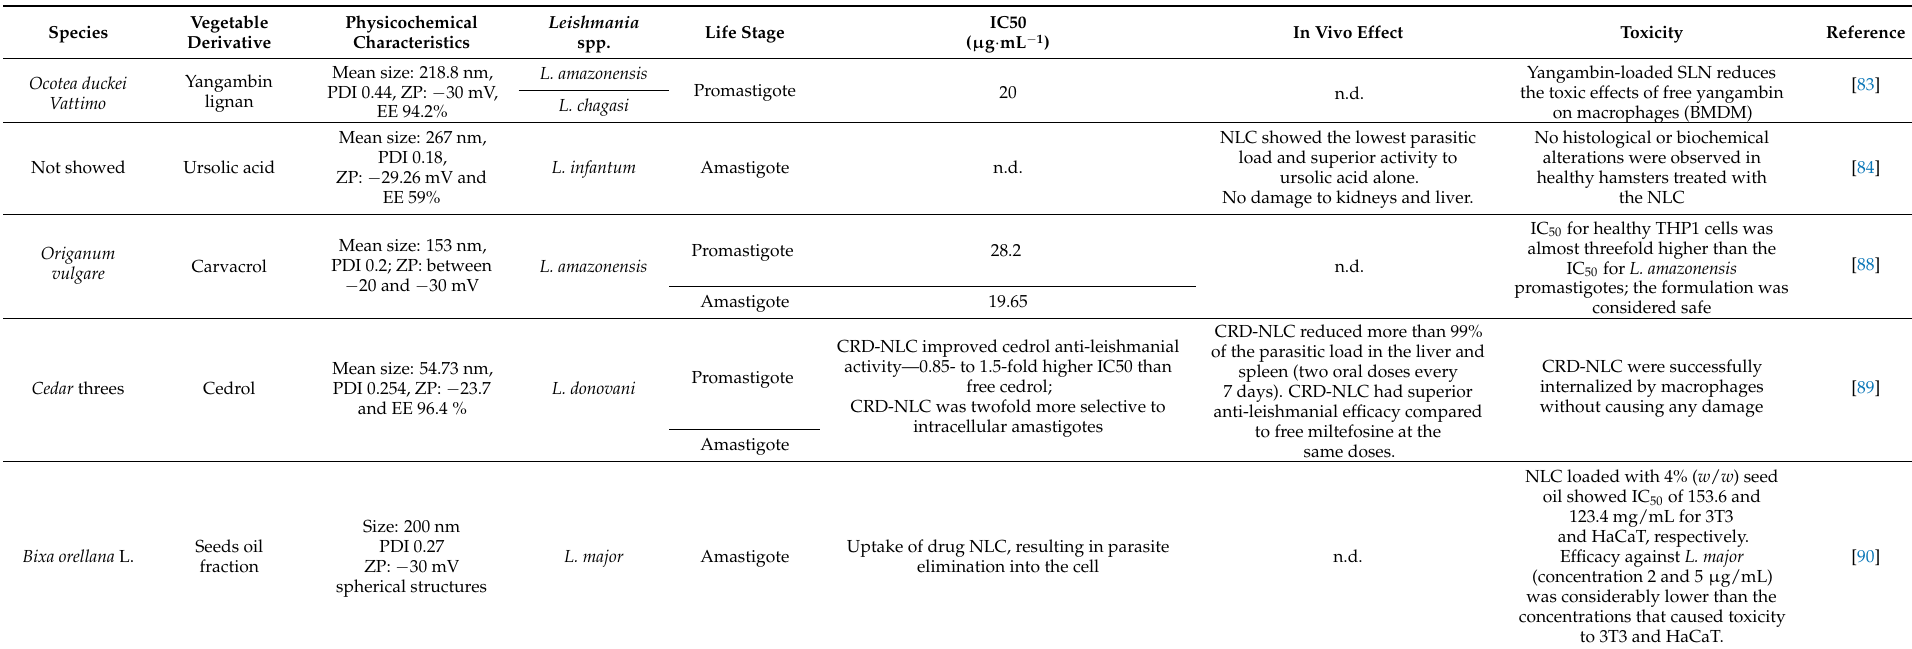
Table 3. Plant-based solid lipid matrix (SLN and NLC) delivery systems as anti leishmanicidal